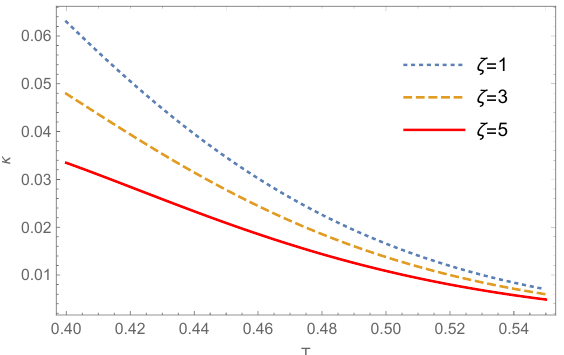
Figure 6 . The dependence of the transition rate of the Hawking-Page phase transition from the large SAdS black hole state to the thermal AdS state on the ensemble temperature T for the exponentially decayed friction kernel. In the plot, L = 1 and γ = 2 .